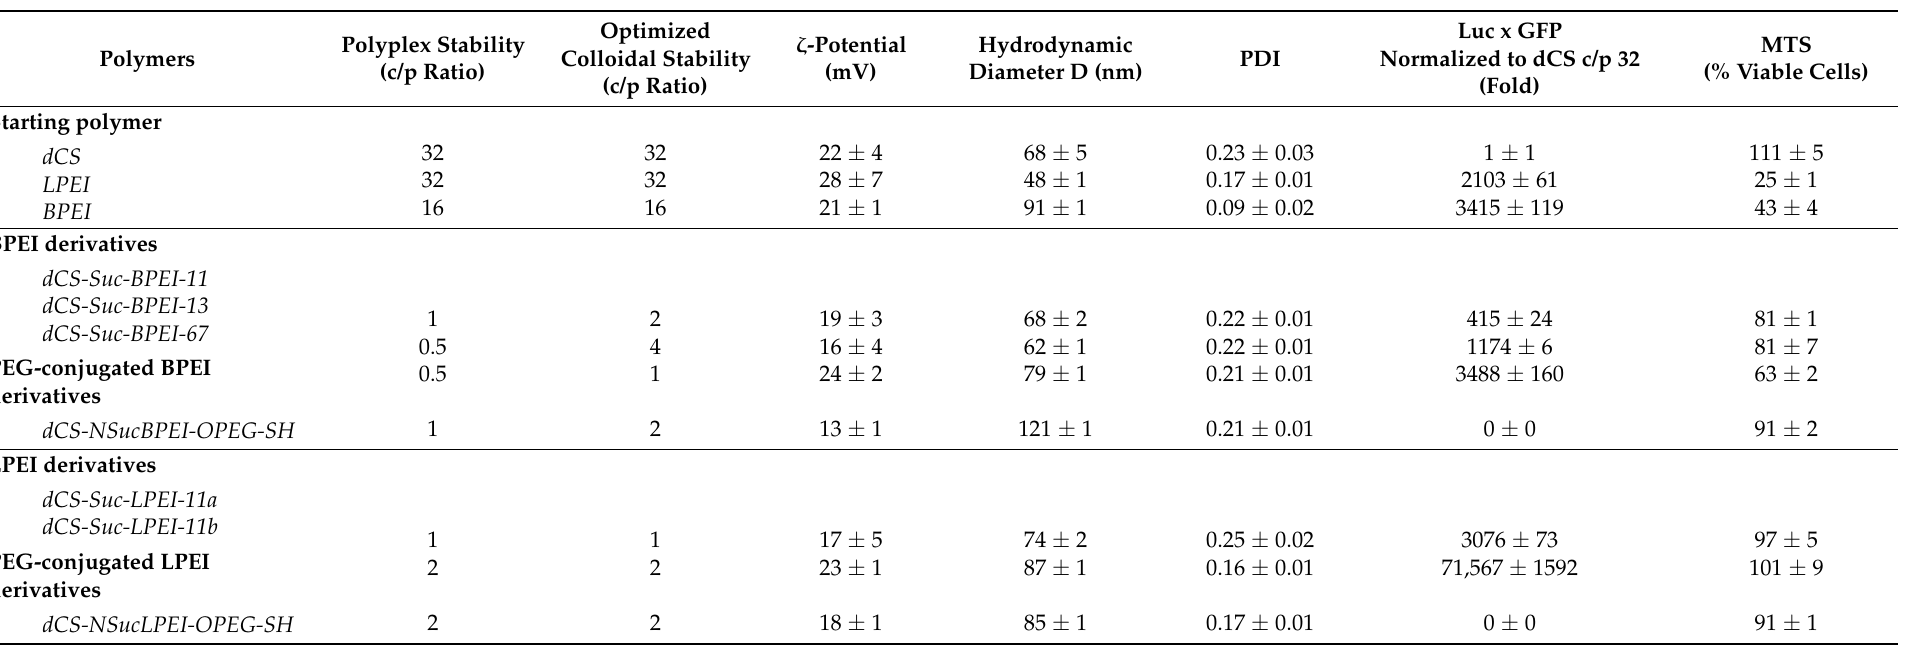
Table 2. Colloidal stability and in vitro performance of DNA complexed dCS-PEI vectors. DNA loading degree is defined by the c/p value (ratio polymer/DNA; % w / w ). Polyplex stability is determined by gel retardation assay. The optimized colloidal stability defines the c/p ratio for their further use in vitro. A polydispersity index (PDI) value equal or below 0.2 is considered to be monodisperse. The in vitro gene expression was determined in the hepatocellular carcinoma cell line HuH-7 using two reporter nanovector-DNA (n.CAGLuc2